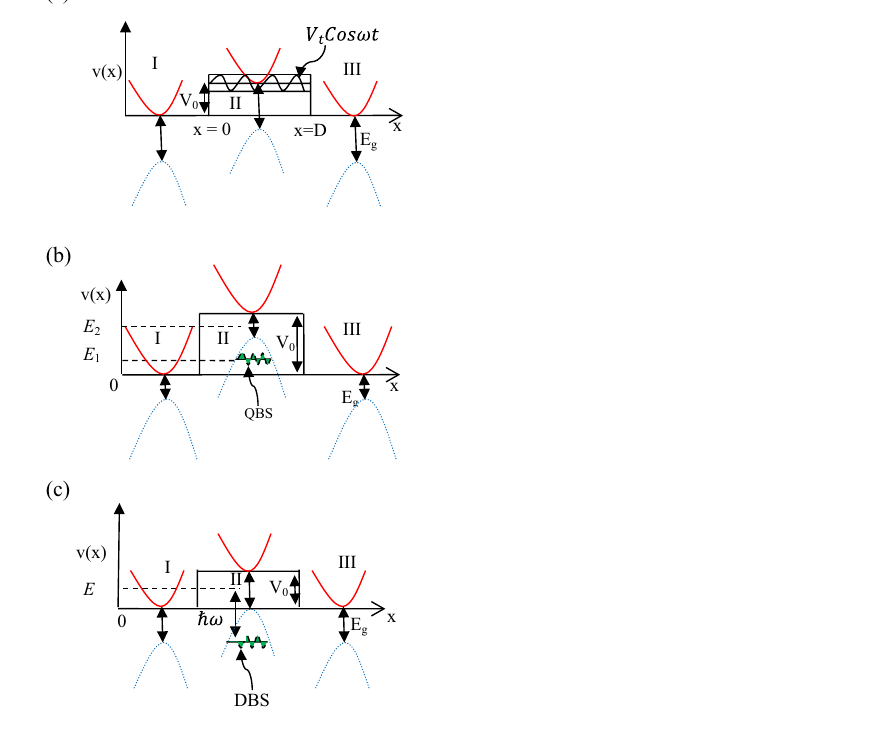
Figure 1. Schematic diagram for the potential profile along the x-axis of a rectangular electrostatic barrier (corresponding to region-II) of height V 0 and width D arising due to shifts of the conduction (solid red line) and valance (dotted blue line) bands relative to the regions I and III by the application of a top electrostatic gate in region II on the phosphorene plane. A small ac signal of amplitude V t and angular frequency ω is applied to the gate in region II. Bottom of the conduction band in region I is taken as the reference level (zero) for measuring energy. ( a )